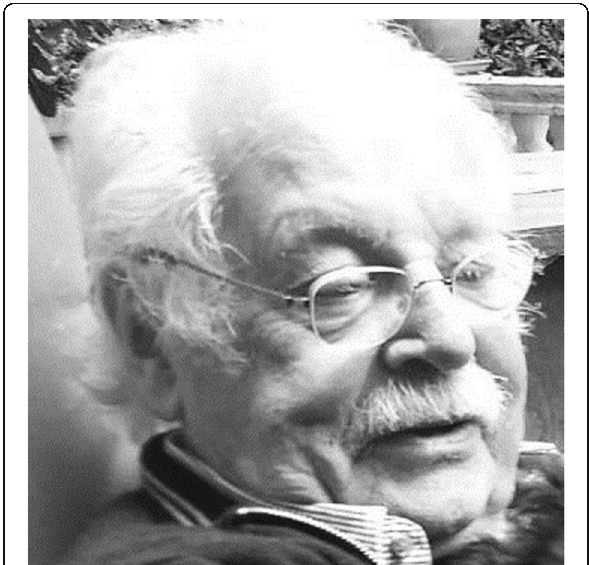
Fig. 18 Jos Wessels. Photo: Jan